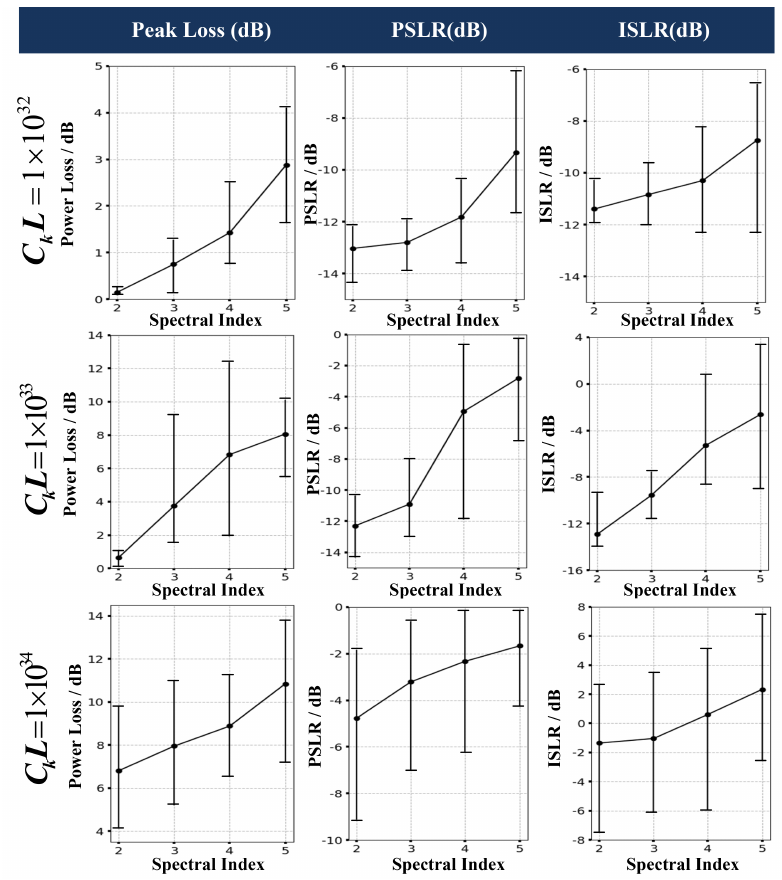
Figure 14. The Monte-Carlo simulation results of the scintillation effect on point